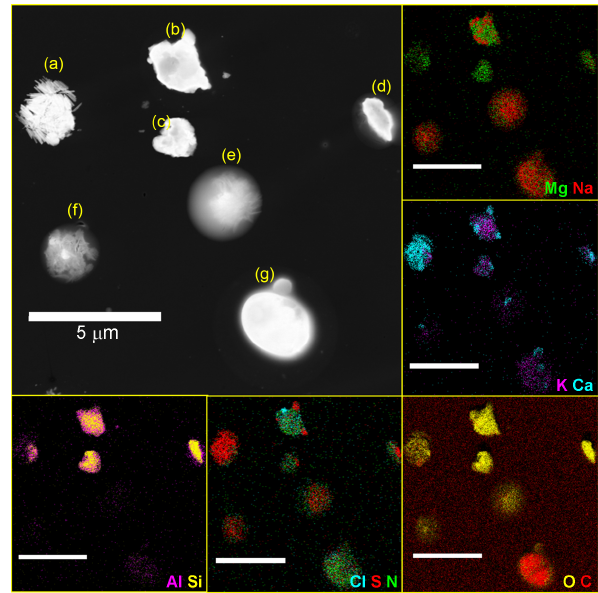
Figure 3. SEM image (dark field) and EDX elemental maps of par- ticles indicated that these particle classes had various mixing states. Each of the elemental map panels corresponds to two elements over- laid to show the elemental distributions from the SEM image. The following particle classes are shown: (a–d) dust, (e–f) aged SSA, and (g) primary